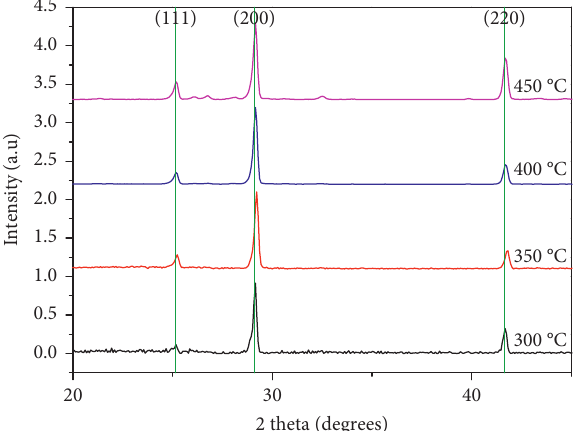
Figure 4: A stacked set of four pXRD spectra showing the dif- fracting pattern of thin films deposited from [Pb((SeP i Pr 2 ) 2 N (S 2 CNHexMe)] complex at 300, 350, 400, and 450 ° C. The green lines are PbSe matching